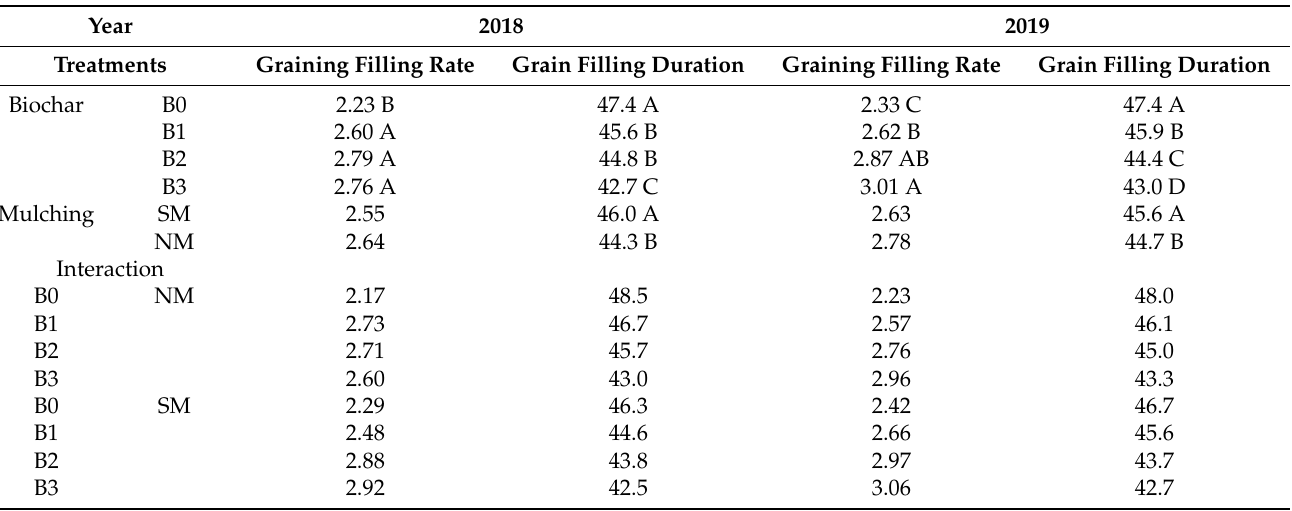
Table 6. Interactive impact of straw mulch and biochar application rates on the grain filling rate and duration of the maize